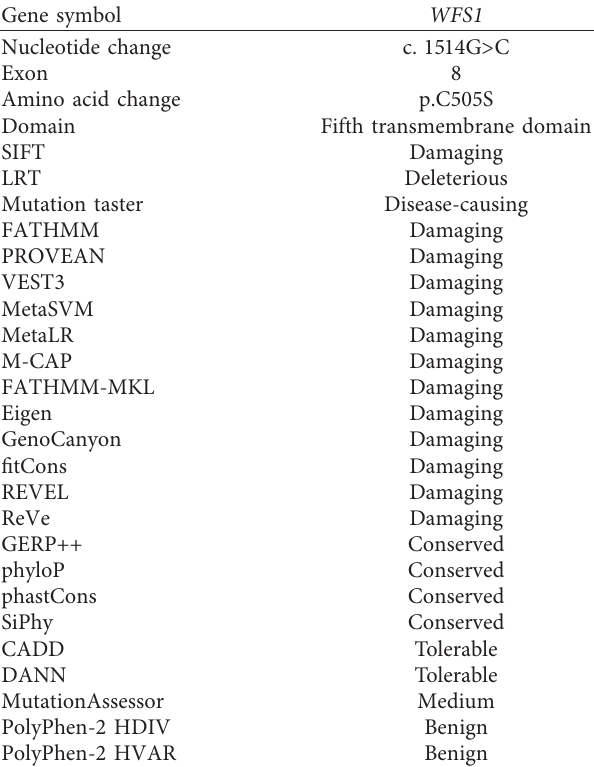
Figure 3: Mutant screening sequencing alignment diagram for family. (a) The sequence chromatogram (forward strand) shows a het- erozygous c.1514G > A transition that causes a substitution of serine (S) for cysteine (C) at codon 505. The arrow points to the position of the mutant nucleotide. (b) The sequence chromatogram (forward strand) shows a heterozygous c.70C > Ttransition that causes a substitution of threonine (T) for proline (P) at codon 24. The arrow points to the position of the mutant nucleotide. Table 1: Functional prediction results by twenty-four software programs and